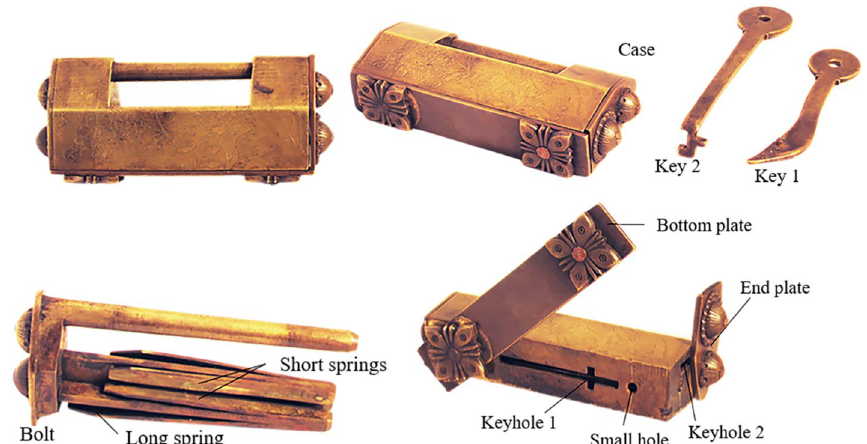
Figure 15. Prying bottom-plate lock.